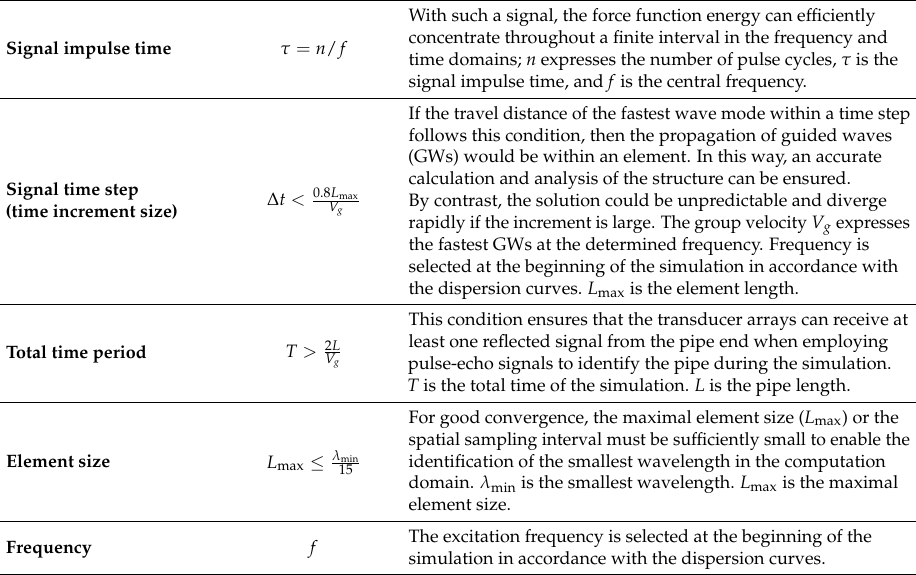
Table 2. Selection of parameters for FE models based on the parameter formula description.